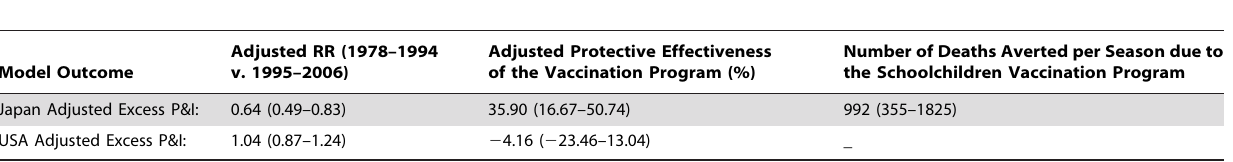
Table 2. Relative risks of excess P&I death among seniors aged 65–89 in 1995–2006 compared to 1978–1994 in Japan and the US, controlling for influenza subtype dominance, population aging, and trends in baseline risk of